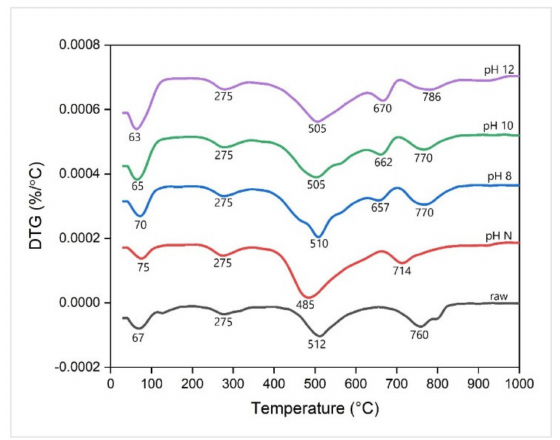
Figure 7. DTG curves of raw and carbonated Fe − rich mine waste samples at initial pH, pH 8, pH 10 and pH